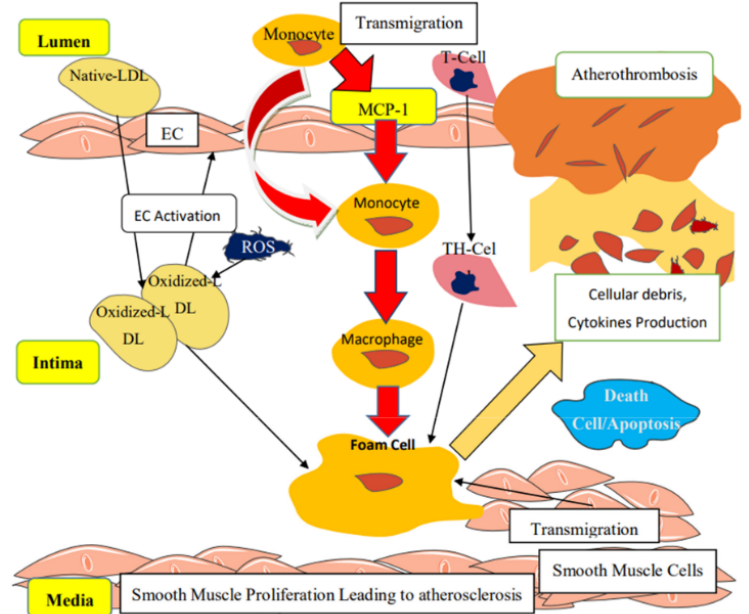
Figure 2. The process of atherosclerosis, adapted by Kwaifa et al. [14]. LDL, low-density lipoprotein; EC, endothelial cell; ROS, reactive oxygen species; TH, thrombocyte; MCP-1, monocyte chemoattractant protein-1.